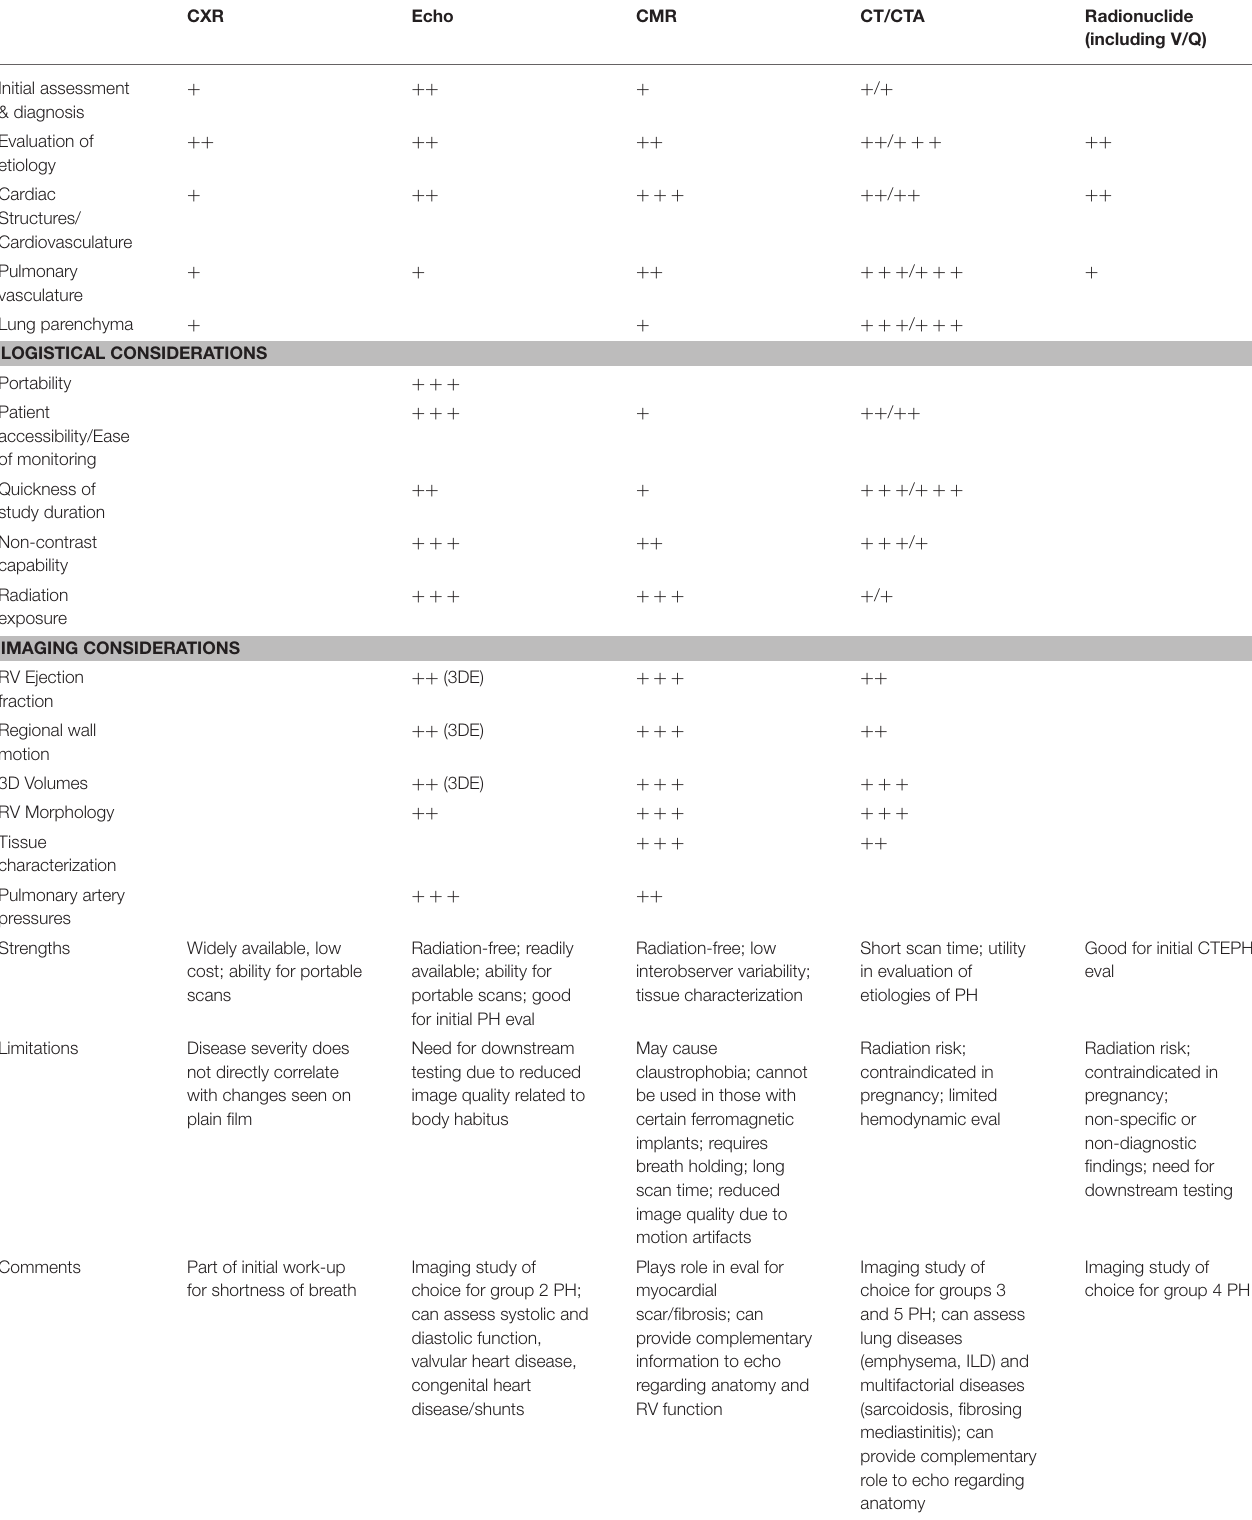
TABLE 1 | Relative strengths and limitations of non-invasive imaging modalities used in pulmonary hypertension. CXR Echo CMR CT/CTA Radionuclide